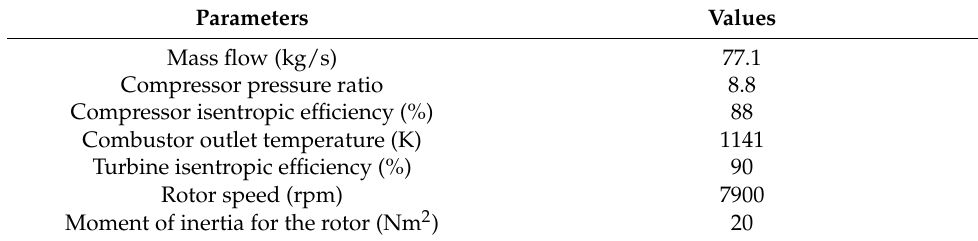
Table 3. Parameters chosen for the modelling of the engine.